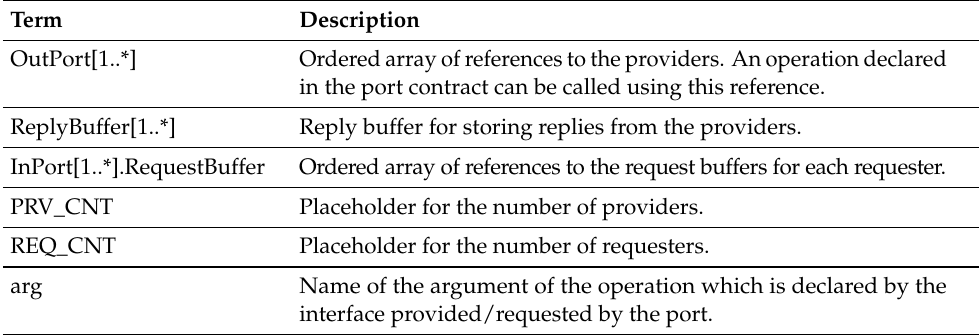
Table 1. Special terms used in connector behavior